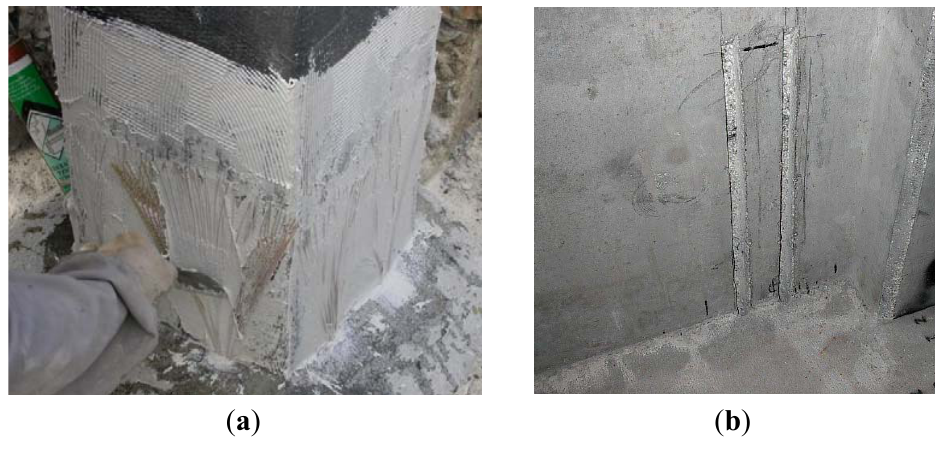
Figure 28. Reinforcement continuity at column/wall to footing connection: ( a ) FRP